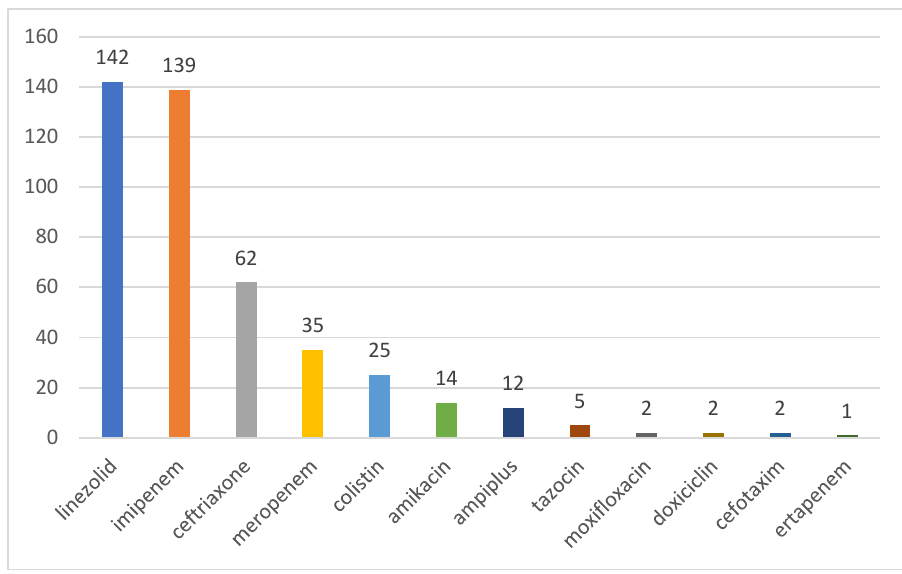
Figure 3. Antibiotics used in ICU COVID-19 patients.